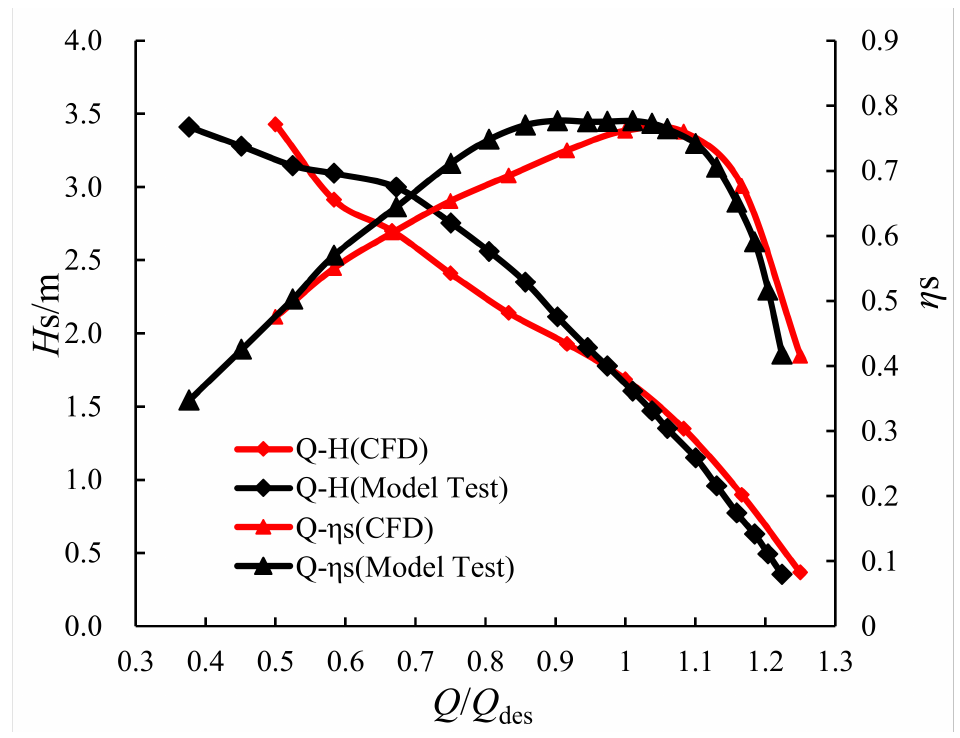
Figure 7. Performance comparison between numerical simulation and model test.